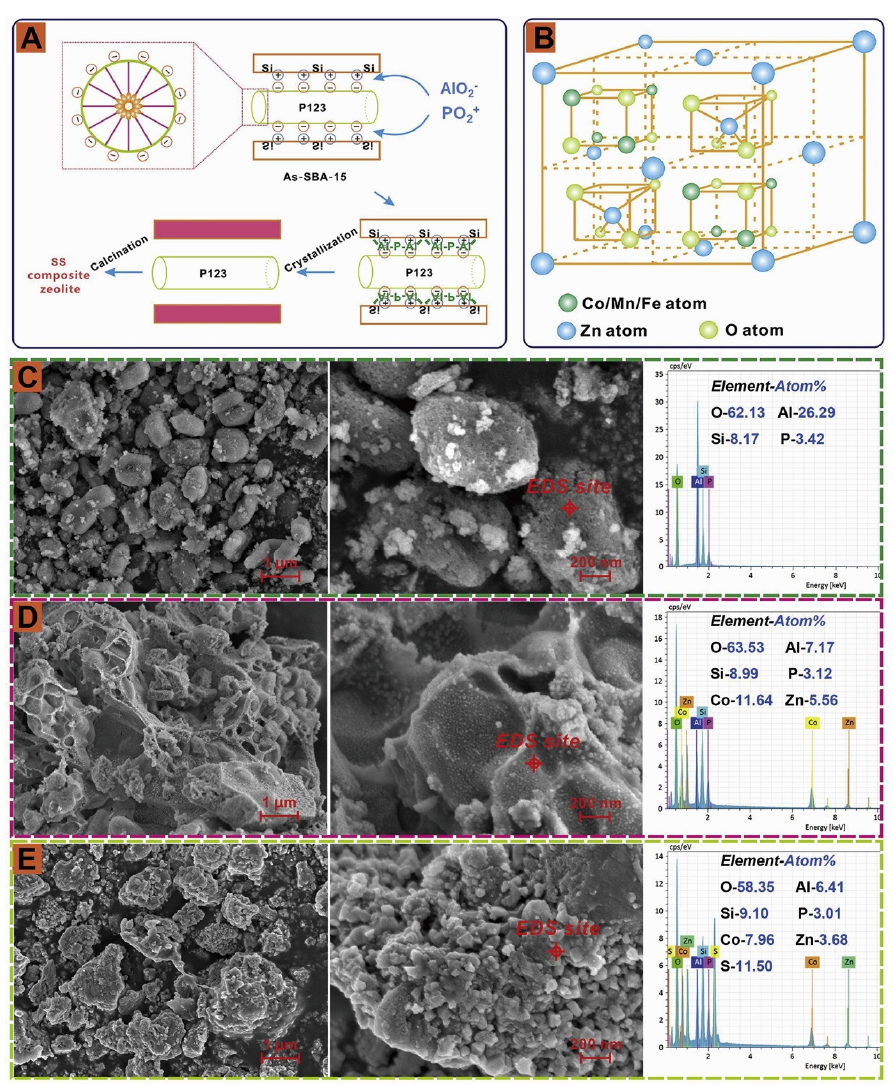
Figure 7. Schematic diagrams of ( A ) synthetic SS composite and ( B ) ZnCo 2 O 4 structure. SEM photographs and EDS spectra of ( C ) SS, ( D ) ZnCo 2 /SS and ( E ) S-ZnCo 2 /SS. Reprinted with permission from Ref. [92]. 2020, Elsevier.